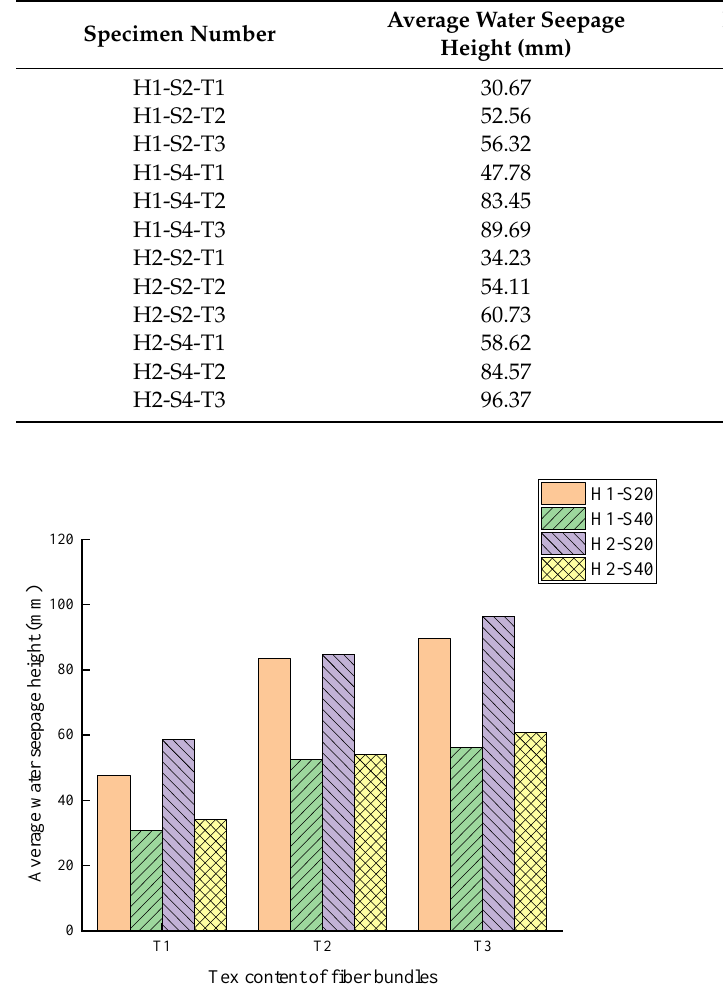
Figure 7. Average water seepage height.